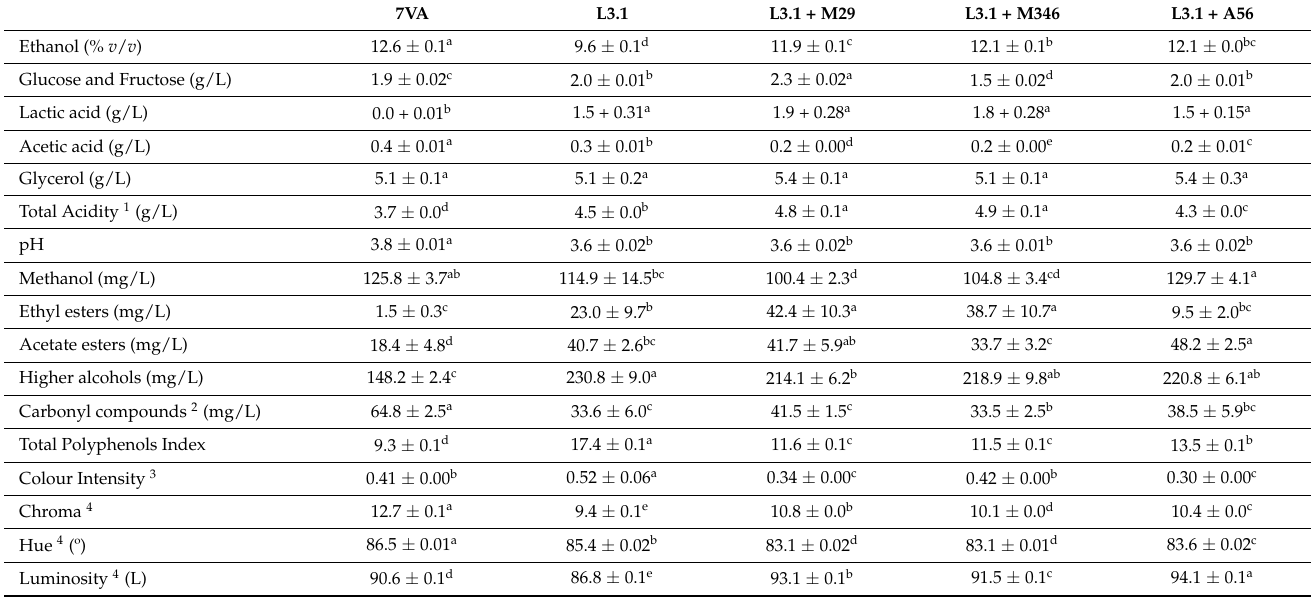
1 Expressed as tartaric acid; 2 Comprises: acetoin, diacetyl, acetaldehyde; does not include butanediol; 3 Obtained from the sum of the following wavelengths: λ 420 nm, λ 520 nm, and λ 620 nm; 4 From CIELab and CIECh coordinates; average and standard deviation for n = 3. Different letters indicate statistical differences ( p < 0.05) between treatments of each fermentative